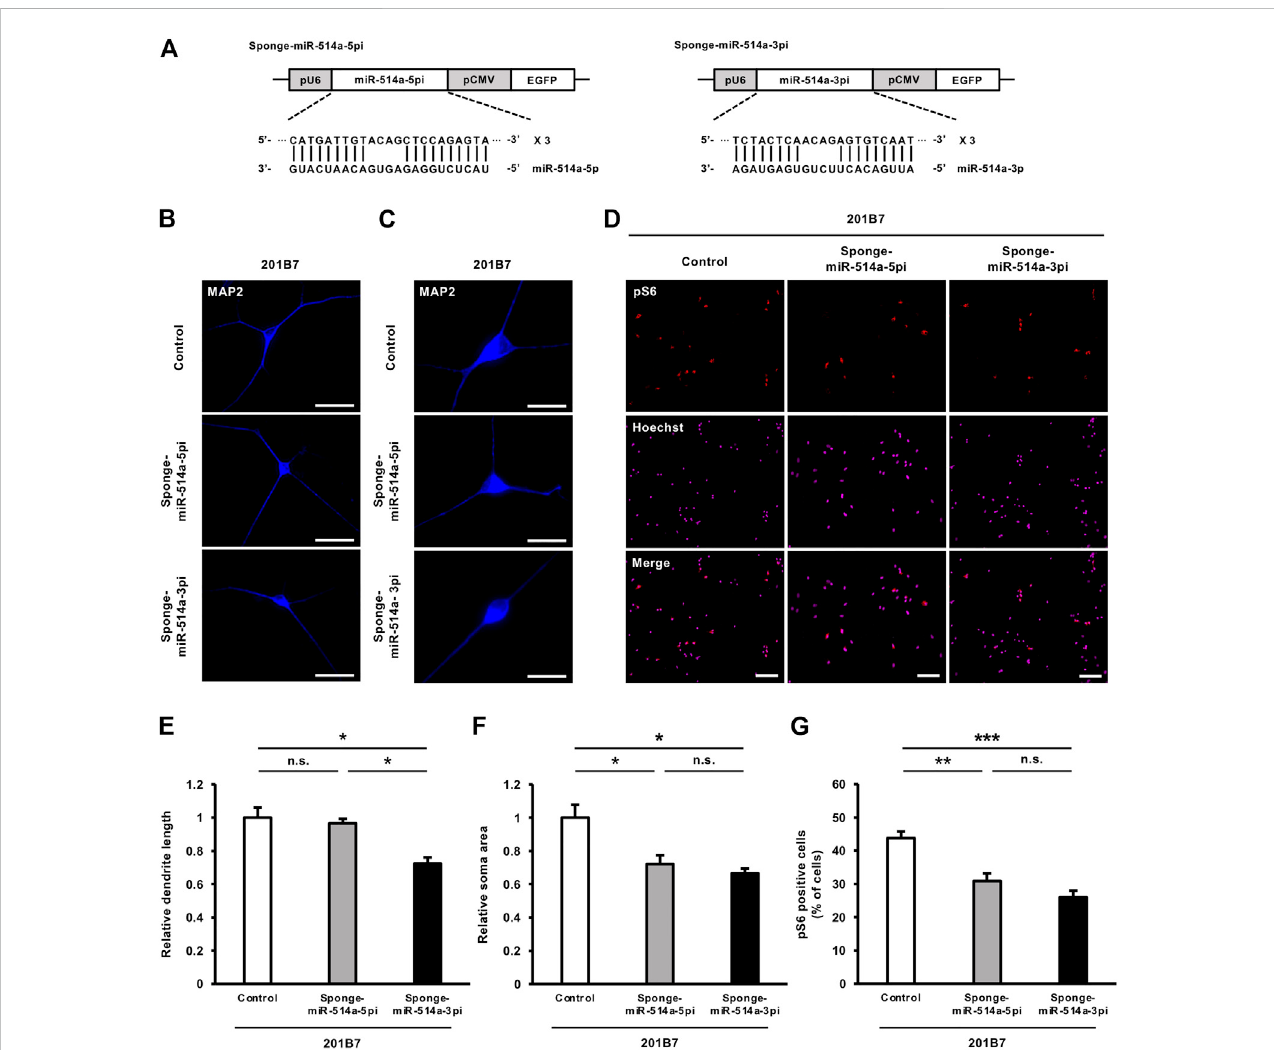
FIGURE 5 Blocking miR-514a using its sponges causes inhibition of neuronal development in iPSC-derived neurons. Neurons were infected with lentiviruses expressing miR-514a-5p sponge, miR-514a-3p sponge or scrambled shRNA as control and cultured for 7 days. (A) Diagrams of lentiviral vector constructs expressing sponges against miR-514a-5p and miR-514a-3p. The sponges were expressed underthe U6 RNApolymerase Ⅲ promotor, and EGFP is expressed undertheCMVpromotor. (B) RepresentativeimagesofiPSC-derivedneurons(201B7)stainedwithanti-MAP2(blue)antibodyat7DIV.Scalebars,50 µm. (C) Representative images of iPSC-derived neurons (201B7) stained with anti-MAP2 (blue) antibody at 7 DIV. Scale bars, 25 µm. (D) Representative images of iPSC-derivedneurons(201B7)stainedwithanti-pS6(red)antibodyandHoechst33,258(magenta)at7DIV.Scalebars,100 µm. (E) Quantitativeanalysisoftotal dendrite length. n = 3 independent experiments, at least 100 neurons were analyzed in each experiment. (F) Quantitative analysis of neuronal soma size. n = 3 independent experiments, at least 100 neurons were analyzed in each experiment. (G) Quantitative analysis of pS6 positive cells. n = 3 independent experiments, at least 200 cells were analyzed in each experiment. n = 3 independent experiments. *** p < 0.001, ** p < 0.01, * p < 0.05. Abbreviations: CMV, cytomegalovirus; EGFP, enhanced green fl uorescent protein; MAP2, microtubule-associated protein 2; pS6, phospho-S6 ribosomal protein; n. s., not signi fi